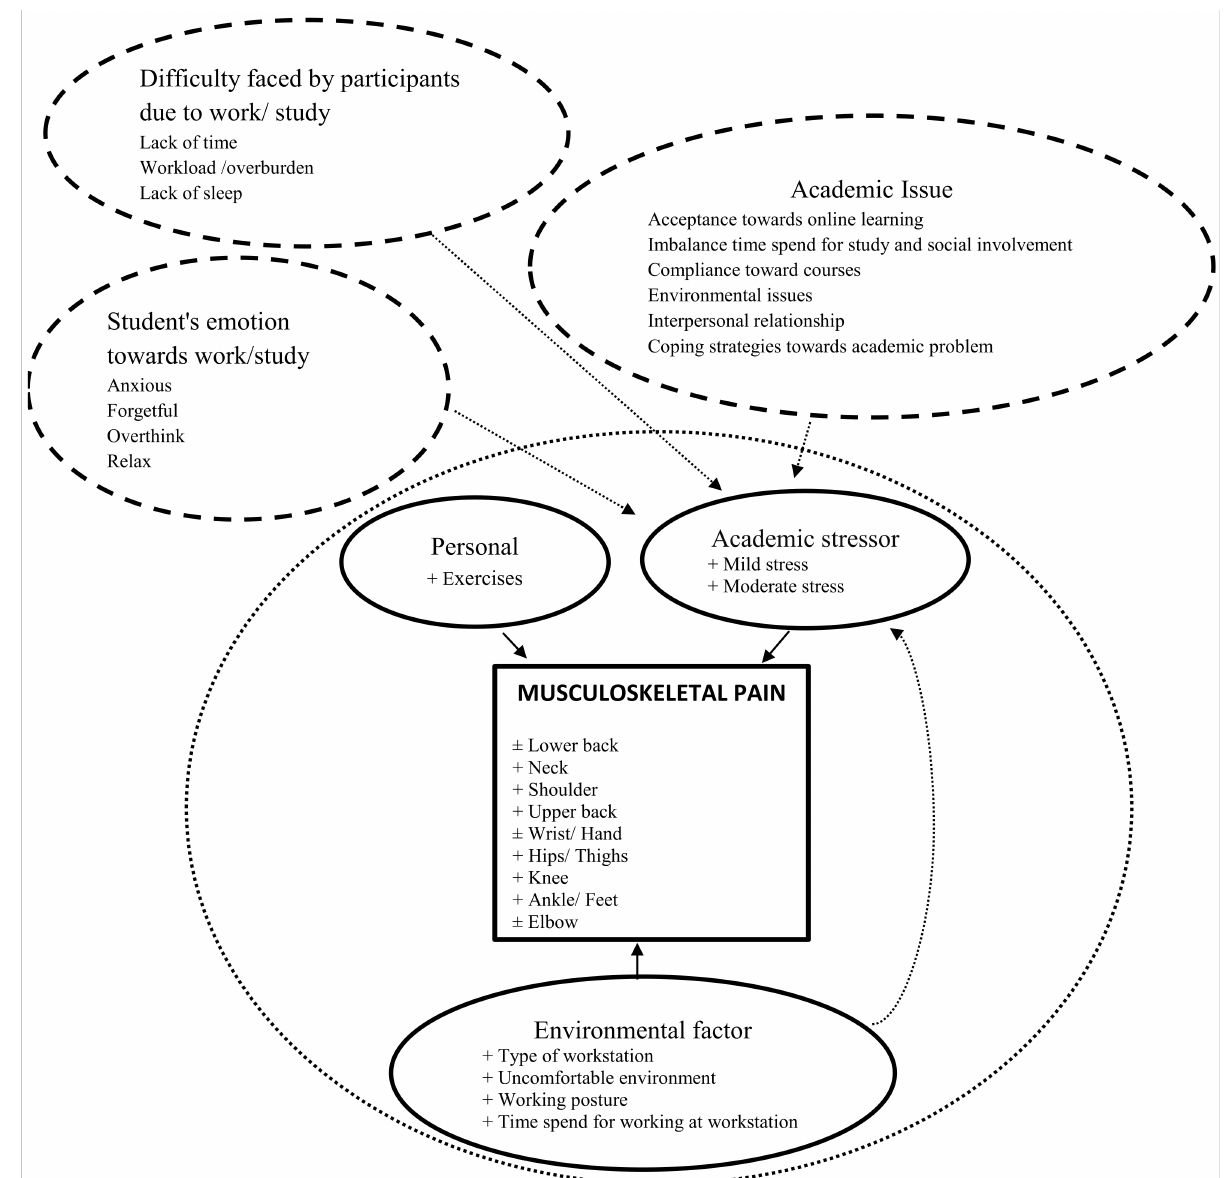
Figure 3. Triangulation model integrating quantitative and qualitative findings (small dots circle), +agreement, ± partial agreement. Supporting data from qualitative findings are included (dashed